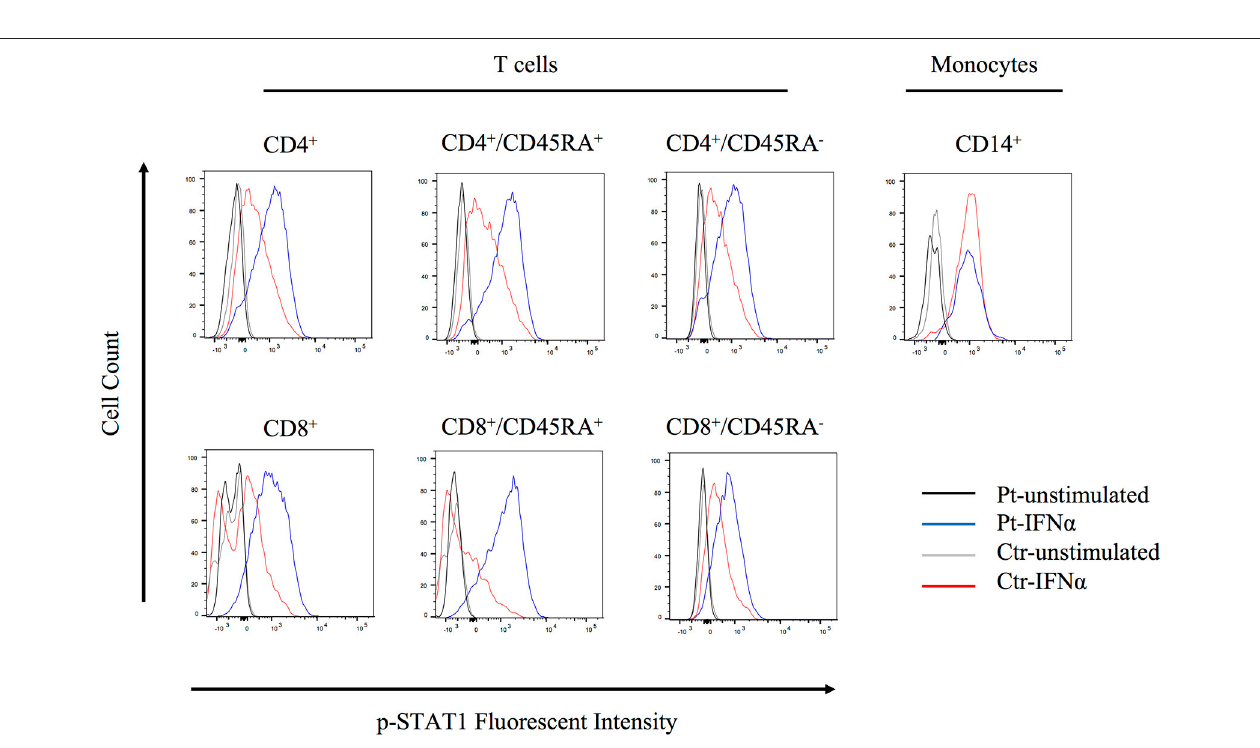
FIGURE 4 | showing the expression patterns of differentially expressed genes regulated by IFN α 2 in whole blood (C) and PBMCs (D) . (E) M-A plot analysis showing differentially expressed genes between PBMCs of the HOIP deficient patient and unrelated controls. Red dots indicate genes differentially expressed with statistical significance (edgeR, p < 0.001). (F) Heatmap showing the expression of 28 genes in PBMCs that are known to be upregulated in monogenic type I interferonopathies. (G) Heatmap showing the expression pattern of differentially expressed genes regulated by TNF.